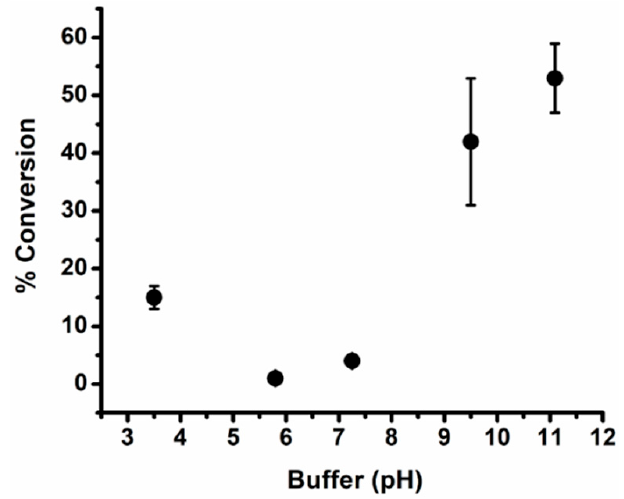
Figure 6. Effect of buffers in hydroxylation of phenyl boronic acid to phenol. Reaction conditions: phenyl boronic acid (0.1 mmol), catalyst (10 mol%), buffer (5 mL of 20 mM carbonate pH 11.1 and 9.5, 20 mM phosphate pH 5.8 and 7.3, and 20 mM acetate buffer pH 3.5), 6 h, 50 °C.